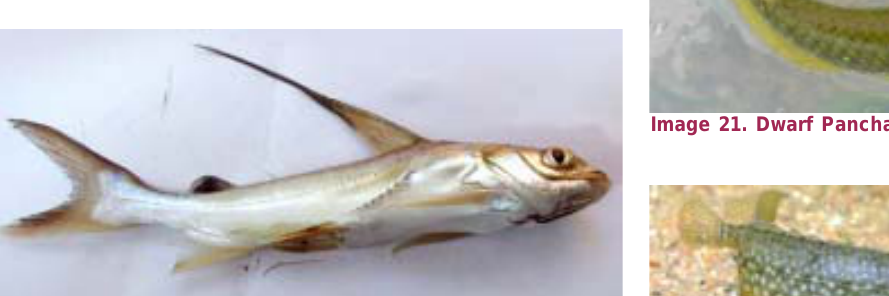
Image 15. Shovelnose Marine Catfish Arius subrostratus